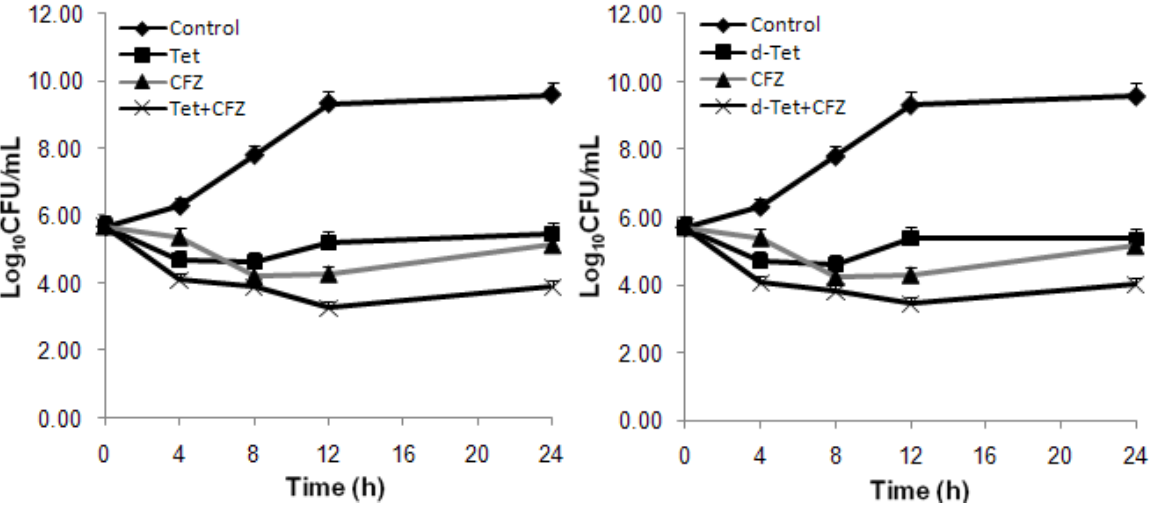
Figure 2. Time-kill curves of the the combination at 1× MIC concentration of tetrandrine (Tet, upper) and demethyltetrandrine (d-Tet, lower) with CFZ, respectively against MRA 276, a clinical MRSA strains of SCCmec III type. The viable cells counts reduced by CFU/mL (both additivity) 1.15 (CFZ) and 1.36 (d-Tet) 1.25 (CFZ) and 1.58 (Tet) log 10 log CFU/mL (both additivity), 10